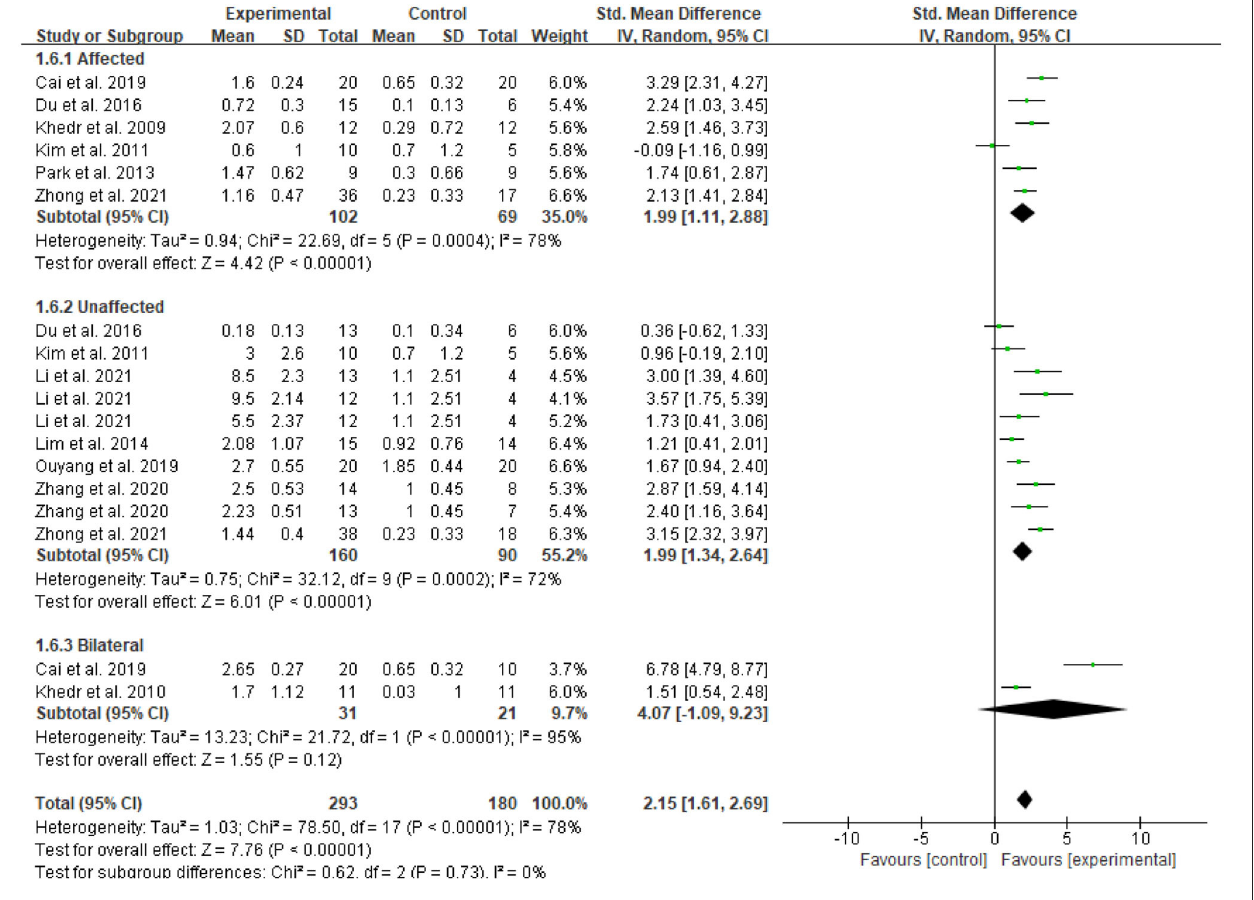
FIGURE 5 | Forest plot for subgroup analysis according to the stimulation